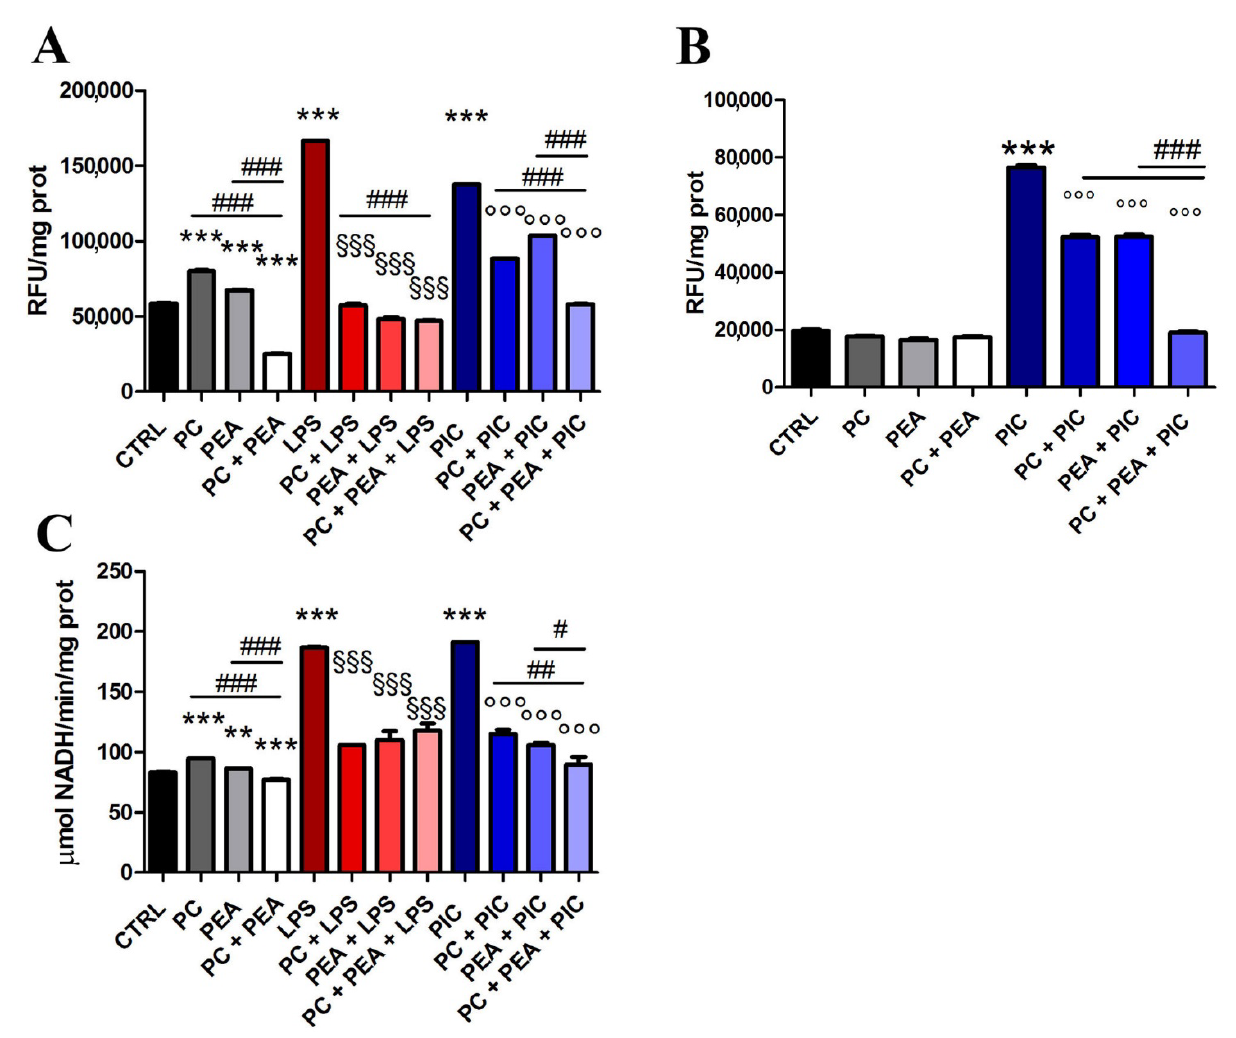
Figure 2. PC and PEA protect cells from oxidative stress and damage. Cells were treated for 24 h either with 20 µ g/mL bacterial antigen lipopolysaccharide (LPS) or with 10 µ g/mL Poly(I:C) (PIC). Cells were also treated for 24 h with 1 µ M PC and 1 µ M PEA, alone or in combination. The intracellular level of ROS was measured both in Beas-2B ( A ) and HPrEpiC ( B ) cells. The values expressed as RFU (Relative Fluorescence Unit) were normalized to protein content. ( C ) The release of LDH was measured in Beas-2B in the culture medium and expressed as enzymatic activity in relation to protein content. Control cells (CTRL) were not treated. Results are means ± SEM. ** p < 0.01 and *** p < 0.001 vs. ctrl; §§§ p < 0.001 vs. LPS; ◦◦◦ p < 0.001 vs. PIC. # p < 0.05, ## p < 0.01 and ### p < 0.001. The latter statistical significance demonstrates the potentiation of the effect when the combination is used vs. single